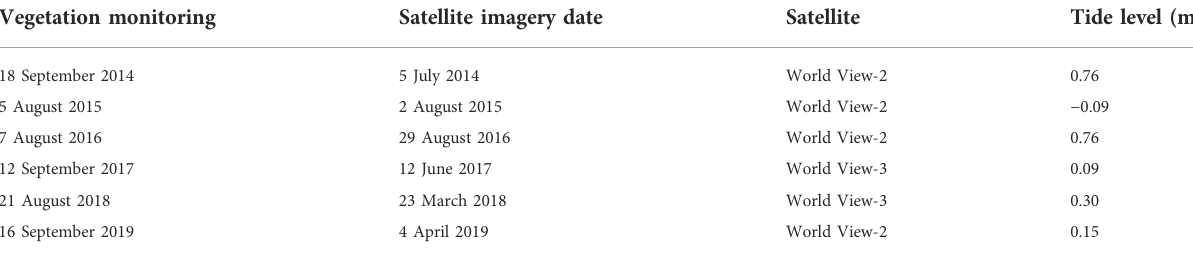
TABLE 1 Dates of vegetation monitoring and satellite image collection used for vegetation change analysis. Tide level is from the Newport, RI, tide station. All satellite images were 4-band, pansharpened imagery with 0.5 m spatial resolution. Vegetation